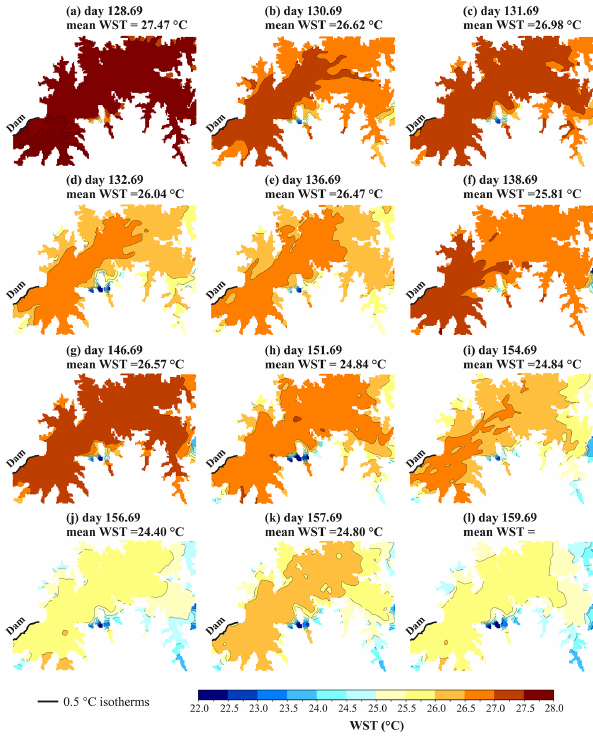
Figure 8. Spatiotemporal variations of WST simulated during the period analyzed (a–l)